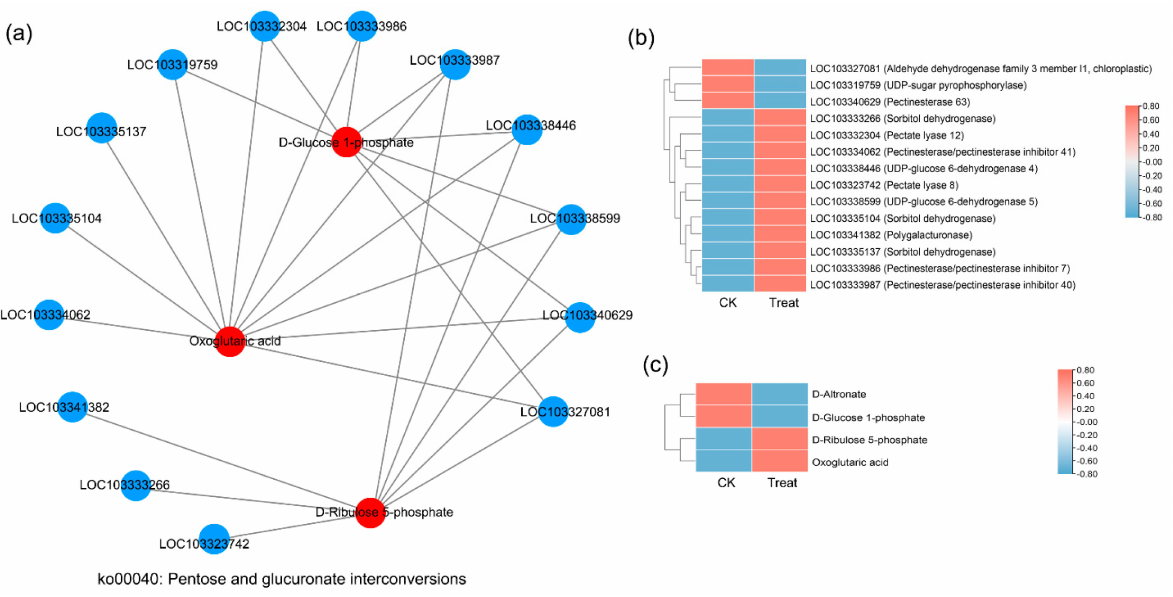
Figure 7. Correlation network diagram of the ko00041 pathway (pentose and glucuronate inter- conversions). ( a ) The correlation network diagram. Red color represents the enriched differential metabolites in the pathway, blue represents the differential genes enriched in the pathway, and the straight line represents the correlation between them. The higher the degree of the node, the more related straight lines, the node is considered more important. ( b ) The heatmap shows the expression level of correlated genes. ( c ) The heatmap shows the accumulation level of correlated metabolites.